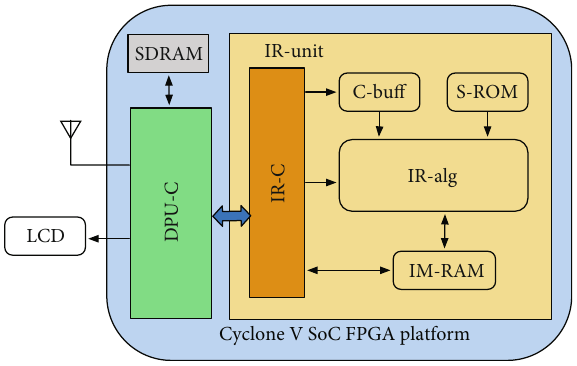
Figure 3: ECT digital processing